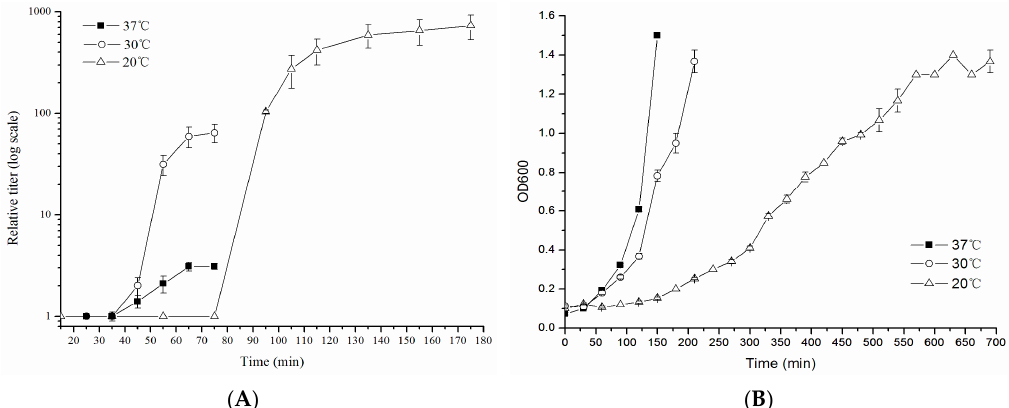
Figure 2. Lytic activity of phage ST32 at various temperatures. ( A ) One-step growth curve of phage ST32 at 20 °C, 30 °C, and 37 °C; ( B ) The growth of E. coli ST130 strain at 20 °C, 30 °C, and 37 °C.